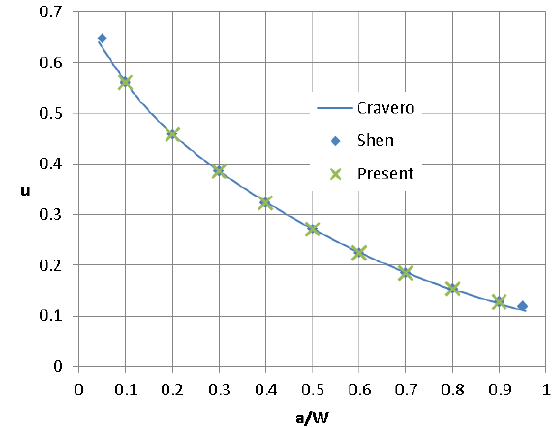
Figure 1: Normalized compliance as a function of a/W.